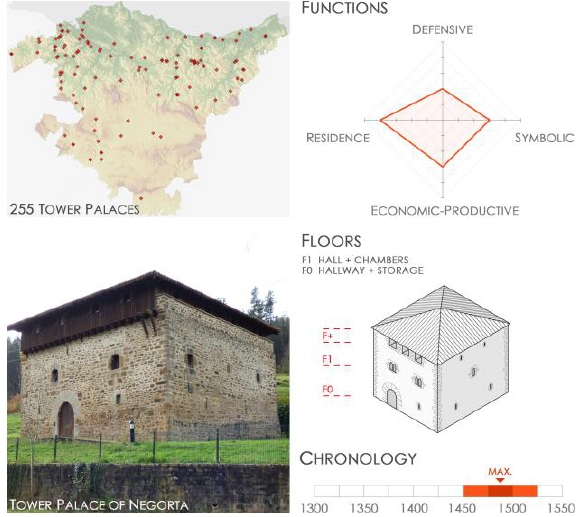
Figure 3. Tower Palaces of the Basque